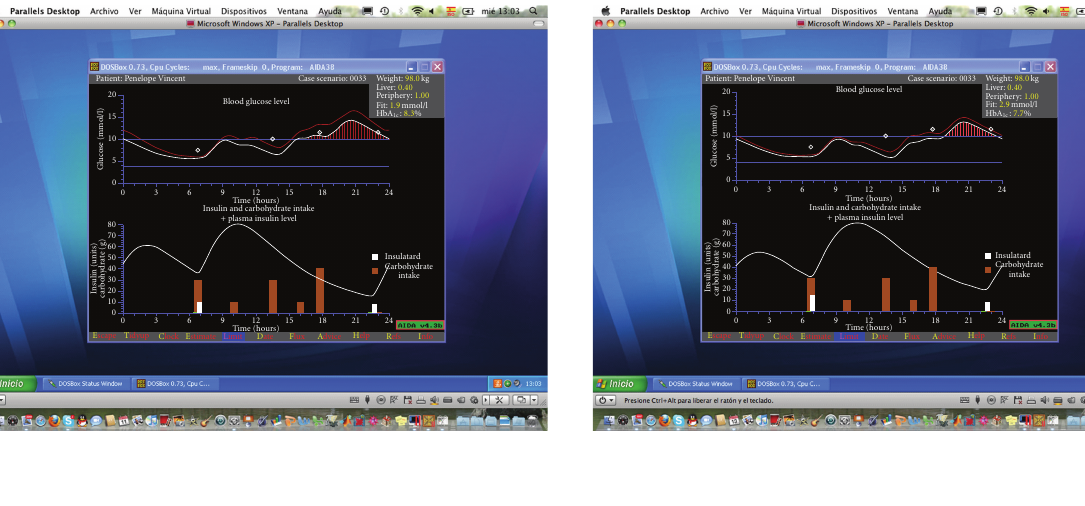
Figure 6: (a) shows the Nullsoft Scriptable Install System (NSIS) in operation—which is used to set up and install AIDA v4.3b on Windows XP, Windows Vista, and Windows 7 PCs, as well as on Apple Macs running PC emulation software. (b) shows AIDA v4.3b operating successfully within a window on a PC running the Windows XP operating system. The e ff ect of increasing the 6 :45am Insulatard insulin injection dose from 10 IU to 15 IU is shown—with a concomitant reduction in the blood glucose (BG) profile. The resulting estimated HbA 1c is calculated by AIDA v4.3b to be improved at 8.0% (down from 8.6% for the previous simulation from Figure 2(c) which is shown as the red BG curve for comparison). (c) AIDA v4.3b operating successfully within a window on a PC running the Windows Vista operating system. The e ff ect of increasing the 6 :45am Insulatard insulin injection dose by 5 more units of insulin to 20IU is shown—with a concomitant further reduction in the blood glucose (BG) profile. The resulting estimated HbA 1c is calculated by AIDA to be further improved at 7.5%. The previous two simulations from Figures 2(c) and 6(b) are shown as the red BG curves for comparison. A user specifiable normoglycaemic range is also shown demonstrating the target range that the user might aim for. BG values are shown in units of mg/dL—much used in North America and other countries around the world. AIDA can present simulation results in both mmol/L and mg/dL. 1 mmol/L of glucose = 18mg/dL. (d) AIDA v4.3b operating within a window on a PC running the Windows 7 operating system. The e ff ect of a change in the carbohydrate intake has been simulated, with a reduction in the size of the 4pm snack from 20 grams of carbohydrate to 5 grams of carbohydrate being shown. This change results in a reduction in the estimated HbA 1c to 7.3% (from 7.5% for the simulation shown in Figure 6(c)—the simulation from which is shown as the red blood glucose curve for comparison on this graph). (e) shows a screenshot from the AIDADEMO application demonstrating for “Joy Wilson,” a 70kg insulin-dependent diabetic patient, the e ff ect of missing her usual morning insulin injection before breakfast with the profound hyperglycaemia (raised blood glucose) that is predicted to occur in the afternoon. (f) shows where the new DOSBox/NSIS packaged release of AIDADEMO is available for freeware download at the AIDA website from http://www.2aida.org/aidademo/. (g) AIDA v4.3b software operating within a window on an Apple Macintosh computer running the Parallels Windows emulation software. The original simulation from Figure 2(b) has been used as the baseline for this example and the e ff ect of reducing each meal and snack by 10 grams of carbohydrate is simulated. As can be seen, this improves the estimated HbA 1c from 9.2% (Figure 2(b)) to 8.3% with a 50 gram per day reduction in carbohydrate intake. (h) A further example of AIDA v4.3b operating within a window on an Apple Macintosh computer running the Parallels Windows emulation software. The simulation from Figure 6(g) is shown as a baseline (in red), and the concomitant e ff ect of increasing the 6: 45am Insulatard insulin injection by 5IU from 10IU to 15 IU is shown with an improvement in the overall blood glucose profile, with a reduction in estimated HbA 1c from 8.3% (Figure 6(g)) to